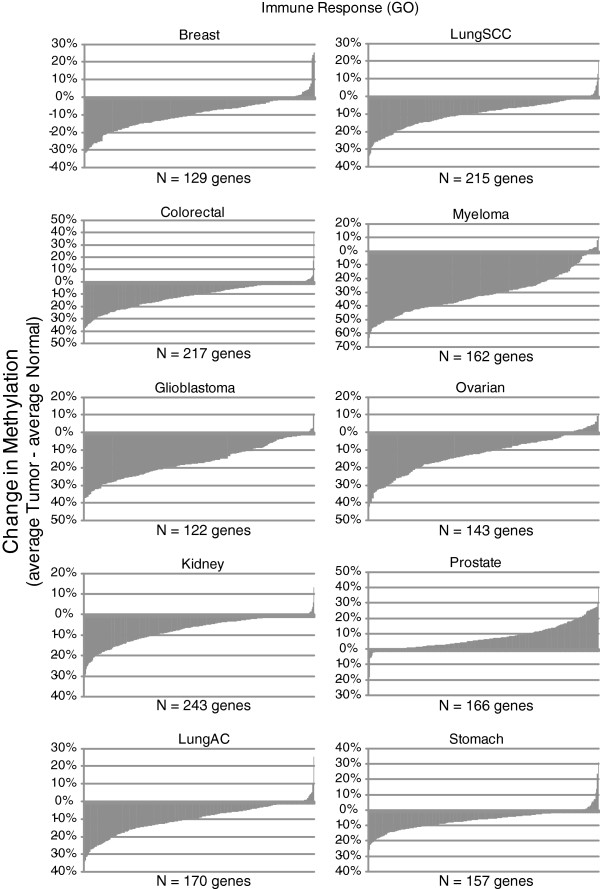
Difference in methylation in significant genes between normal and tumor samples involved in immune response (GO term).Waterfall plots of the average methylation change of those genes involved in immune response (average methylation % among tumor samples - average methylation % among normal control samples) is shown below. All except prostate cancer show a significant number of genes undergoing hypomethylation, a possible mechanism for gene activation.